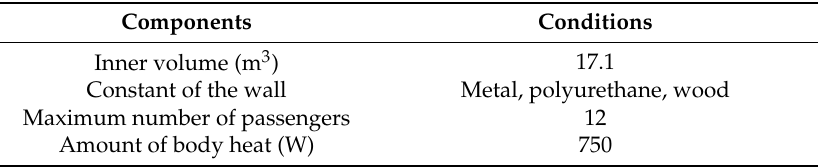
Table 5. Thermal loads for the required air conditioning system